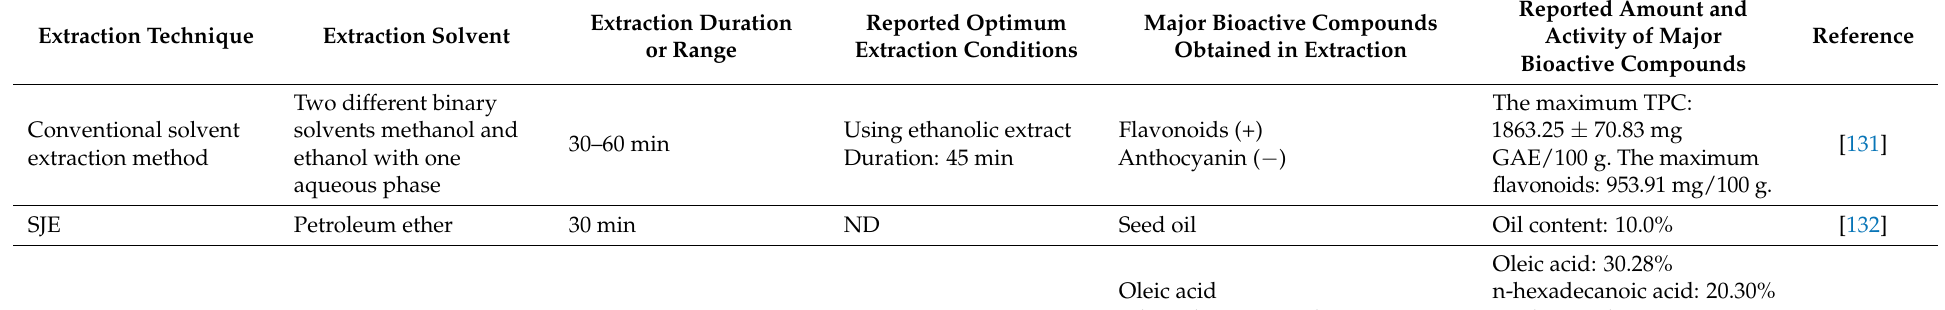
Table 3. Some research results on the extraction of Jamun seeds’ major